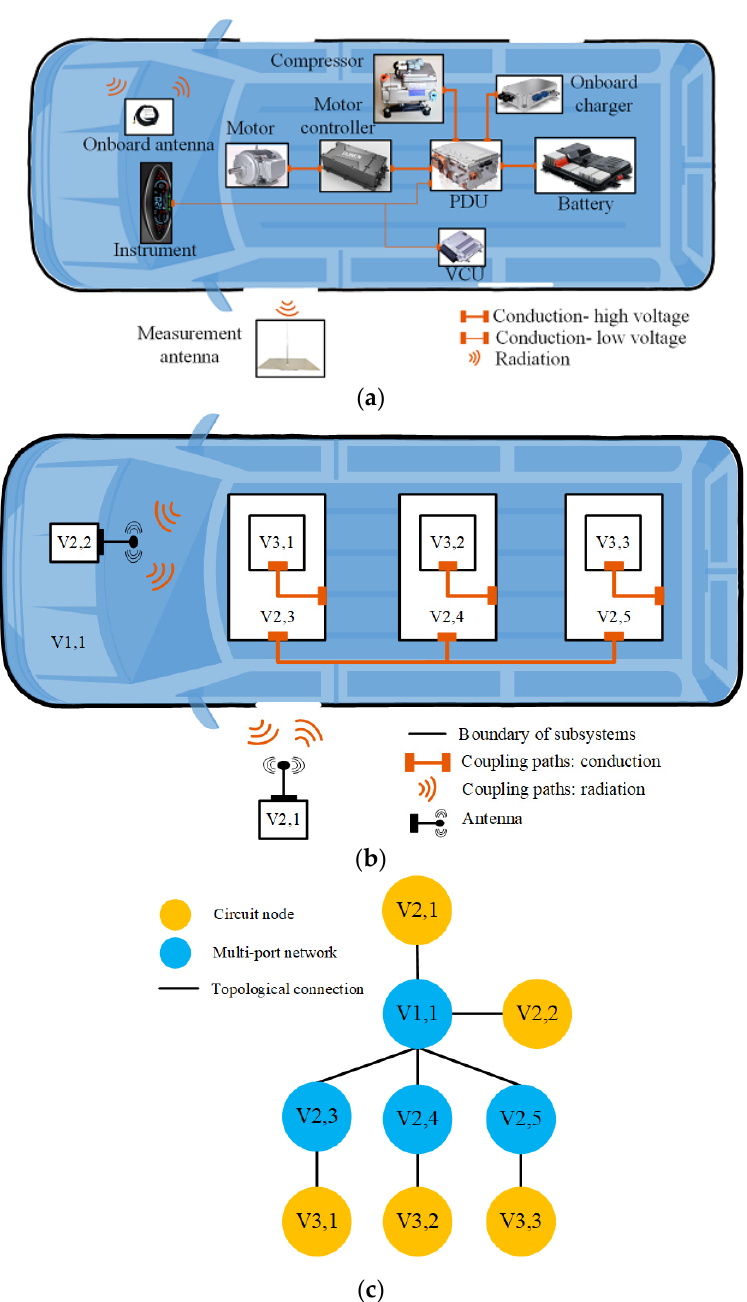
Figure 2. Decoupling process of vehicle radiation problem: ( a ) Original system; ( b ) Equivalent system; ( c ) Topological connection.